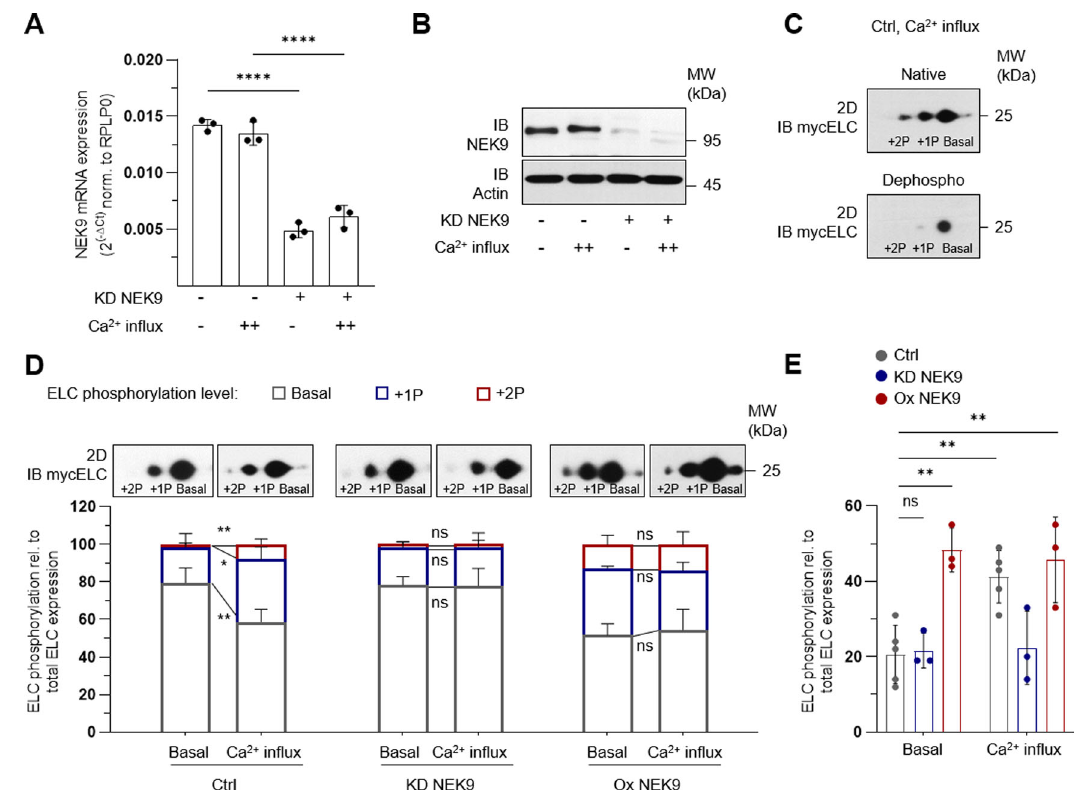
Fig. 3 | NEK9 regulates ELC-phosphorylation pattern in-vitro. A Validation of siRNAmediatedknockdown(KD)ofNEK9inHEK293cellsbyquantitativerealtime PCR. mRNA expression shown as 2 ( − Δ Ct) normalized to RPLP0 (ribosomal protein large subunit P0). Ca 2+ -in fl ux was obtained by ionophore stimulation. Data are mean±SD ( n =3). **** P <0.0001 by analysis of ordinary one-way ANOVA followed by Bonferroni ’ s multiple comparisons test. B Representative immunoblot (IB) of NEK9 proteinexpressionafter speci fi c knockdown (KD). C 2D